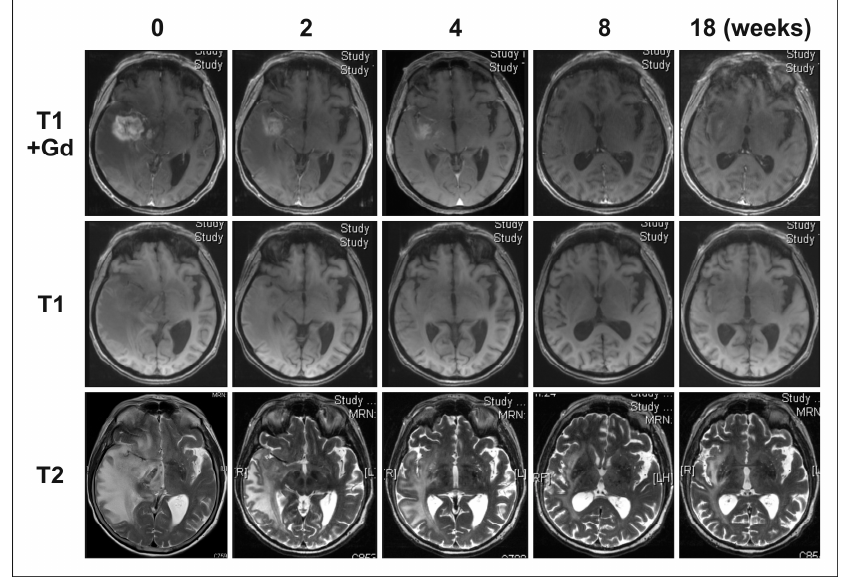
Figure 1. Exemplary magnetic resonance imaging (MRI) of Patient 7: contrast enhancing lesion. T1 sequences with and without Gadolinium contrast enhancer and T2 sequences were obtained at Weeks 0, 2, 4, 8, and 18 after BEV therapy initiation. After BEV therapy initiation contrast enhancing and T2 hyperintensive alterations decreased. At Week 18, a small contrast-enhancing alteration formed and the T2 hyperintensive alterations were increasing.